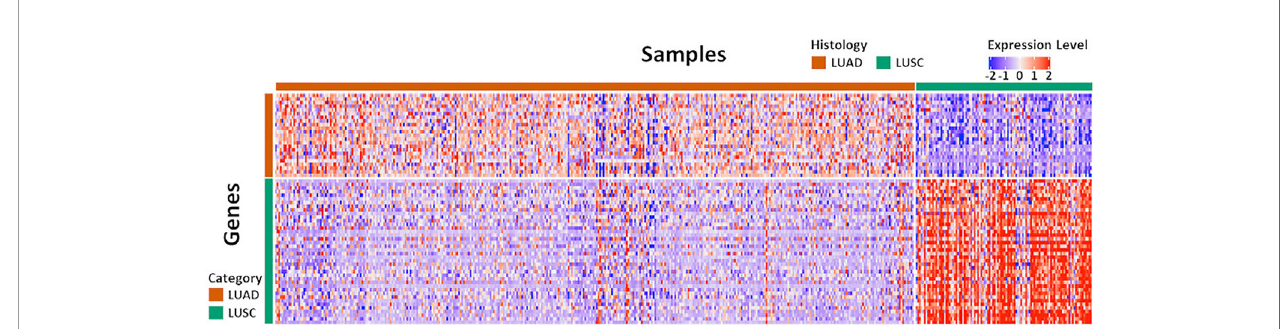
FIGURE 2 | The expression pattern of the 67 diagnostic genes in the Exploration Cohort. The Exploration Cohort was composed of 490 samples collected from LUAD (n = 384) and LUSC (n = 106) tumors. The 67-gene diagnostic panel was composed of 27 LUAD-speci fi c and 40 LUSC-speci fi c genes. The gene expression pattern was derived from the normalized microarray-based transcriptomics data and scaled for visualization.